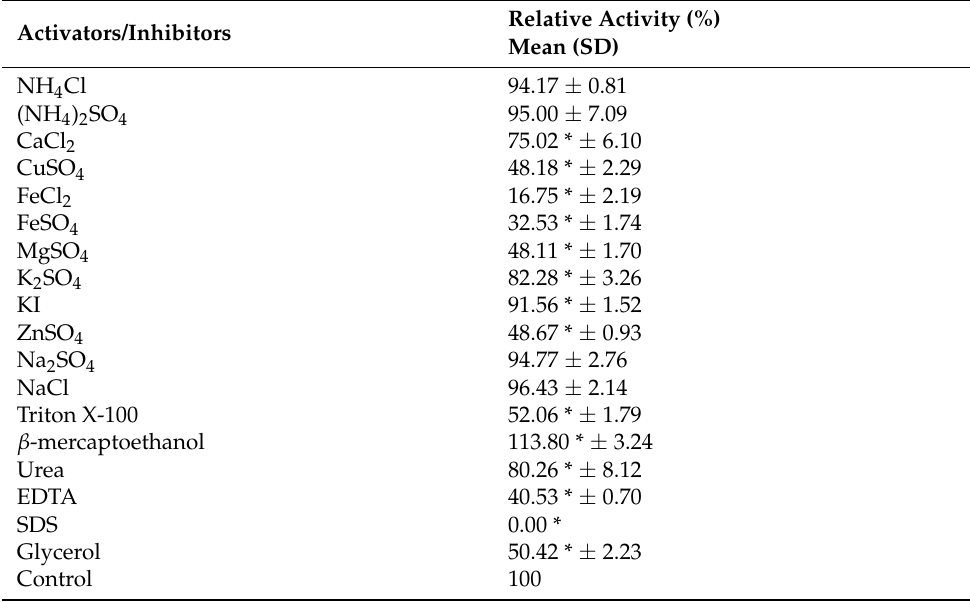
Table 5. Effect of activator and inhibitor agents on lipase activity produced from bati butter.